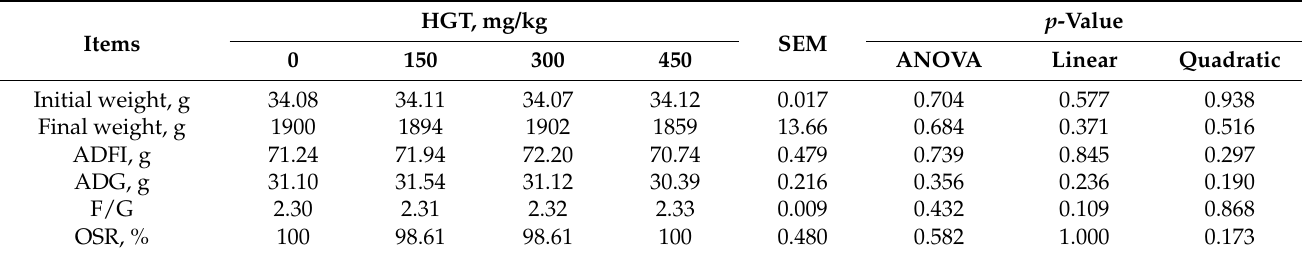
Table 2. The effect of HGT on growth performance of broilers 1